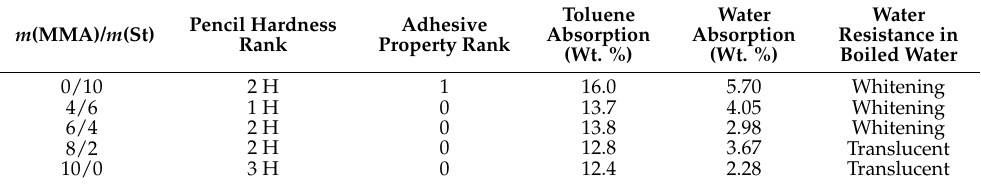
Table 7. Properties of the cured film synthesized by emulsion with MMA and St units in polymer chain. m (MMA)/ m